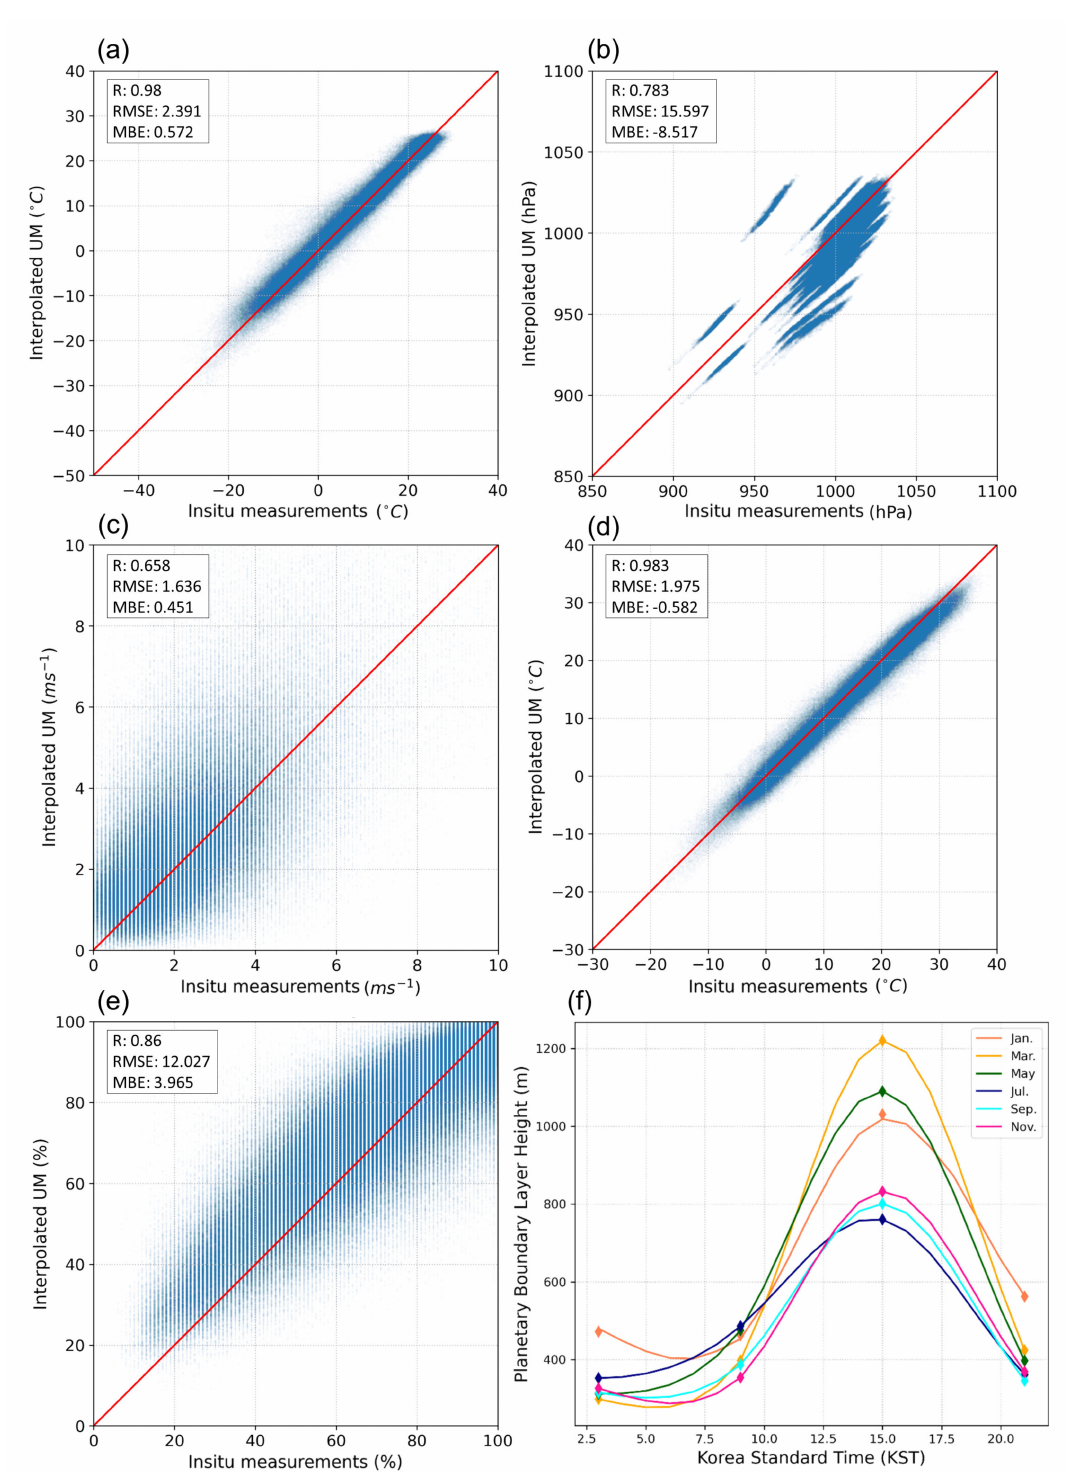
Figure 2. Comparison of in situ meteorological variables and interpolated UM RDAPS: ( a ) dew point temperature; ( b ) surface pressure; ( c ) wind speed; ( d ) 2 m height air temperature; ( e ) relative humidity; and ( f )